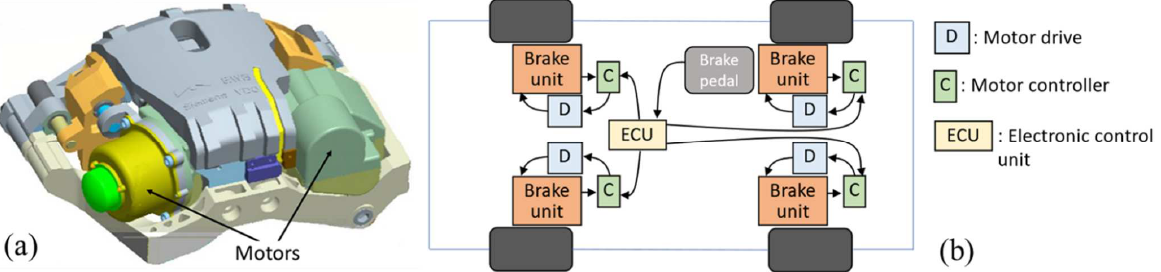
Figure 2. ( a ) A prototype of the electronic wedge brake by Siemens VDO [10], ( b ) General struc- ture of a BBW system [13]. of a BBW system